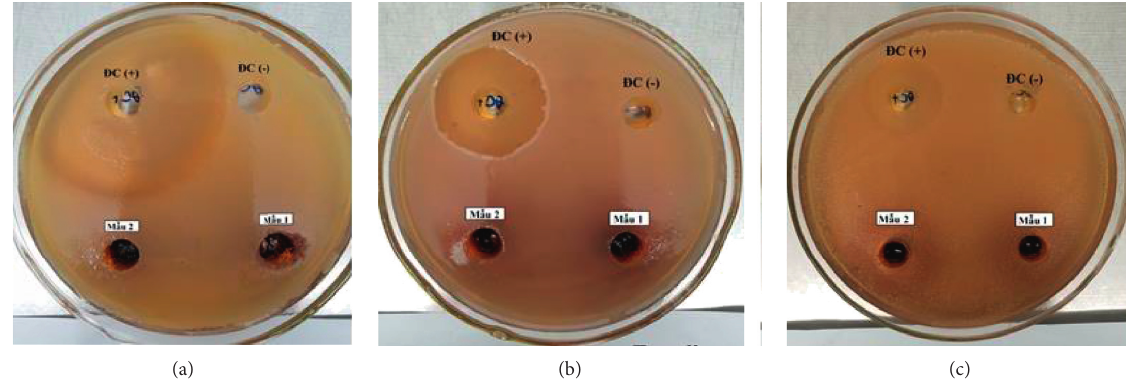
Figure 6: Antimicrobial results: (a) specimens with S. aureus ; (b) specimen with E. coli ; (c) specimen with M. catarrhalis.